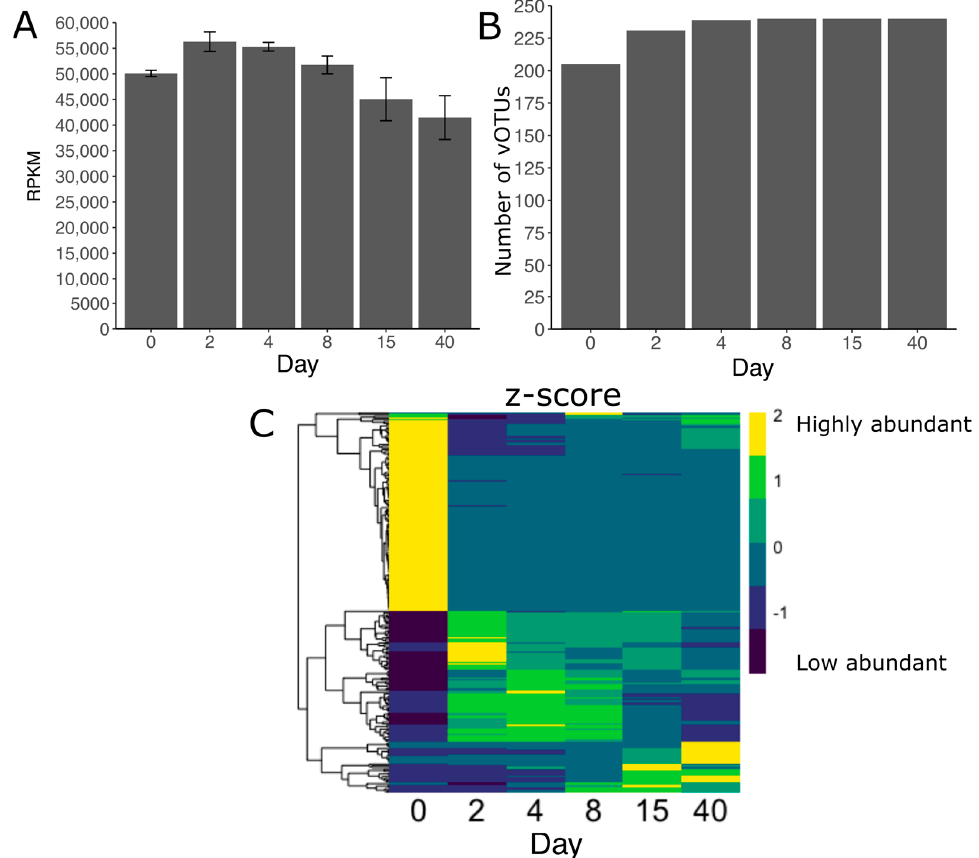
Figure 4. Abundance and diversity of 240 vOTUs recovered from grass ensilaging. ( A ) Total abun- dance of the vOTUs presented as reads mapped per kilobase of contig, per million mapped reads (RPKM). ( B ) Number of vOTUs found per day. ( C ) Differential abundance (z-score) of the vOTUs across sampling time. The heatmap clustering is based on abundance patterns. The vOTUs identified as provirus are not shown in the